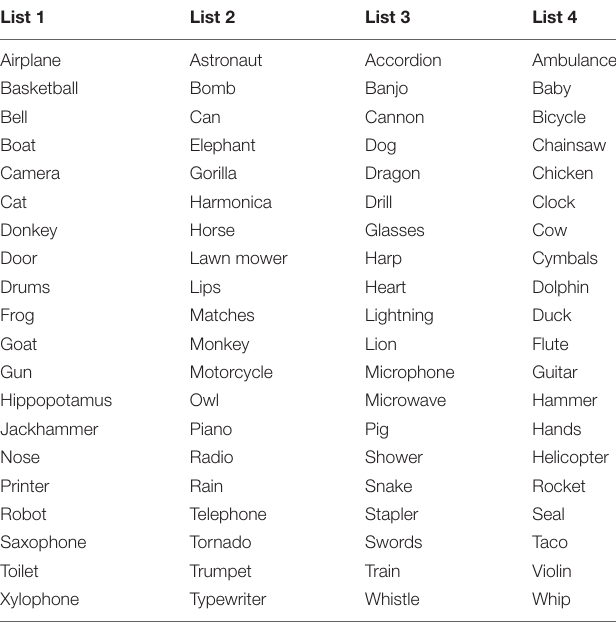
TABLE 2 | List of the environmental sound stimuli used in the present